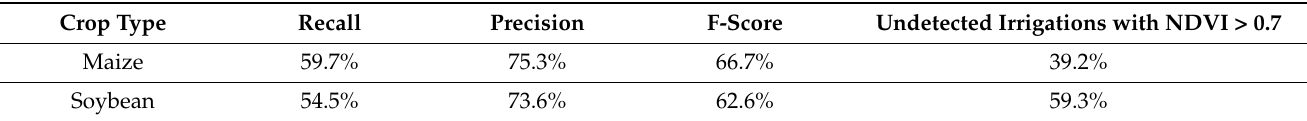
Table 5. Recall, precision and F-score values aggregated by crop